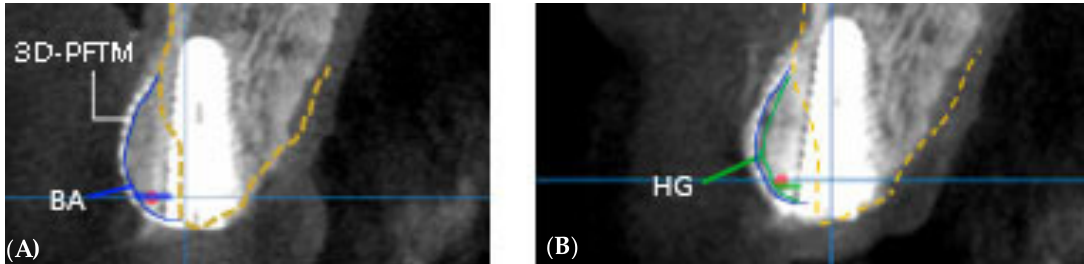
Figure 2. Method of radiographic analysis. A line parallel to the long major axis of the implant and a perpendicular line extending buccally at the level of the implant platform are drawn. ( A ) BA, bone augmentation immediately after surgery; ( B ) HG, hard tissue gain after 6 months of healing. The gap between the blue and green lines indicates bone resorption, while the red spot indicates the bony envelope. 3D-PFTM, three-dimensional preformed titanium mesh.